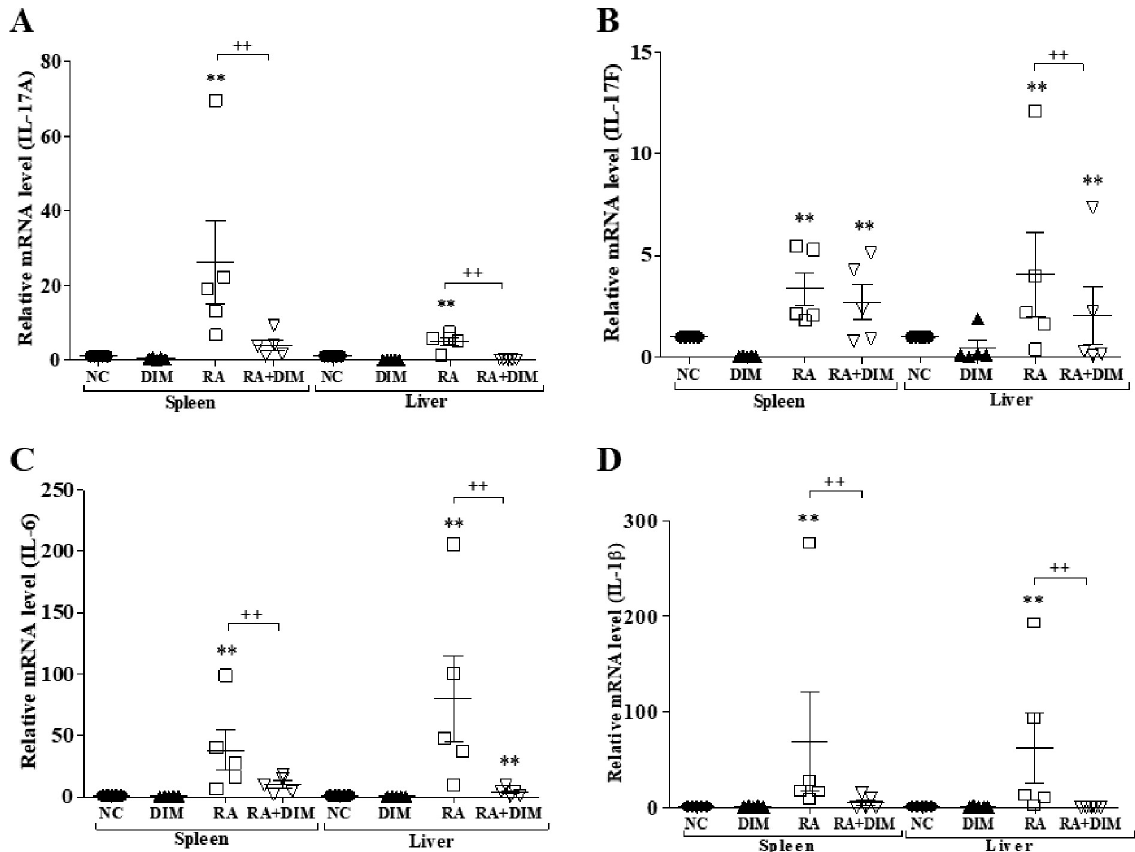
Fig 6. Effect of DIM on the expression of IL-17A and related cytokines in R . anatipestifer– infected ducks. Two-week-old ducks were inoculated intramuscularly with 5 × 10 7 CFU of R . anatipestifer serotype 7 and treated orally with DIM (200 mg/kg/day) by gavage daily from 1 day prior to infection throughout the experimental period. Ducks (n = 5/group) were sacrificed on day 4 after infection. The spleen and liver were aseptically removed, homogenized using a grinder, and subjected to qRT-PCR. The levels of IL-17A (A), IL-17F (B), IL-6 (C), and IL-1 β (D) mRNA were normalized to that of β -actin and calibrated using the expression levels of uninfected/untreated healthy birds (NC). Data are expressed as the mean ± SE of five birds and one representative of two independent experiments. �� P < 0.01 compared to NC. ++ P < 0.01 for the comparison of the infected/untreated group with the infected/treated group. RA, R . anatipestifer ; DIM, 3,3’-diindolylmethane; DPI, days post-infection.